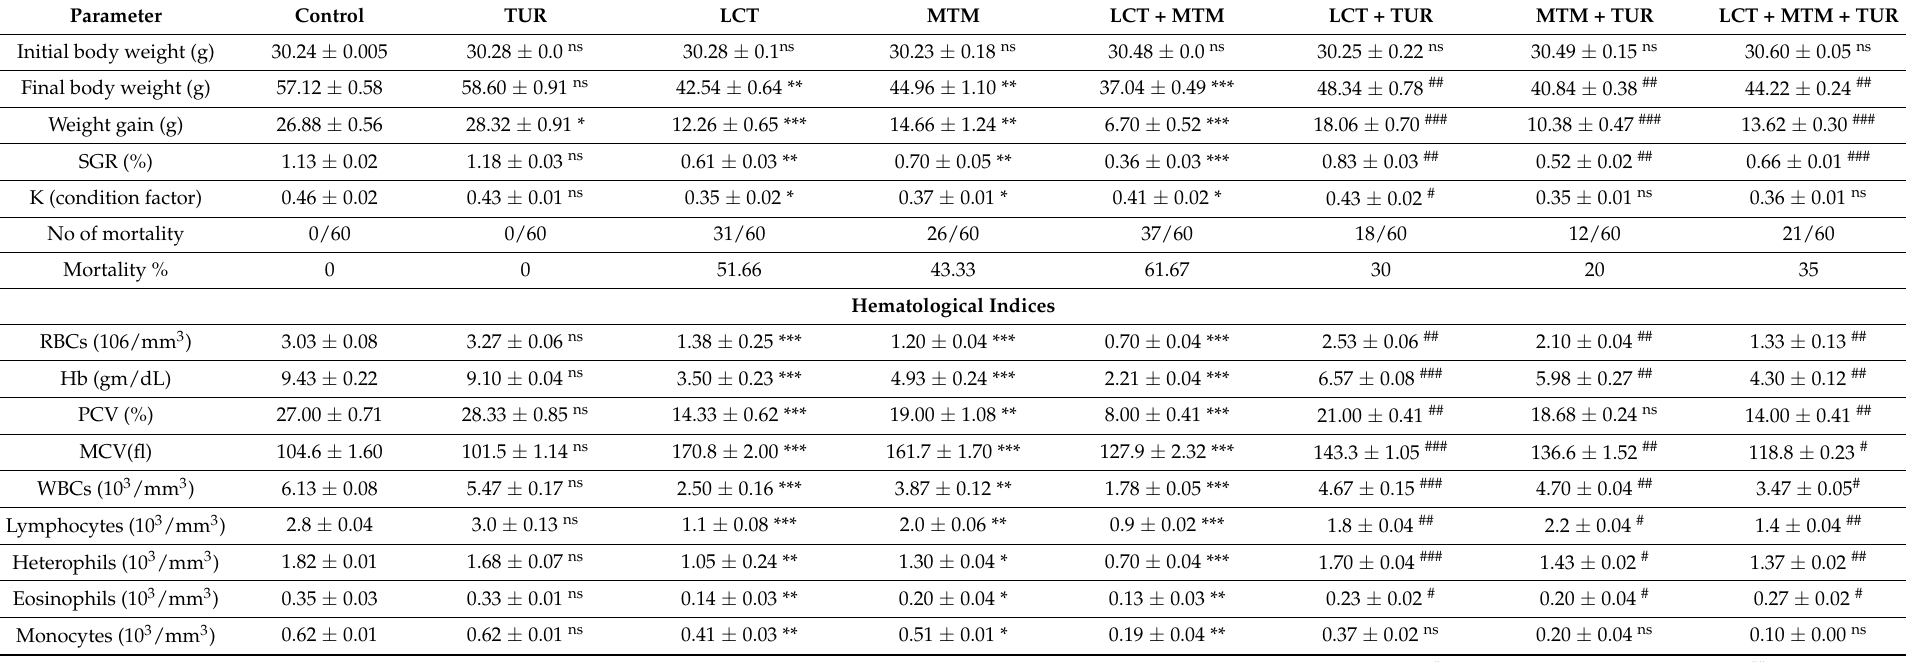
Table 4. Comparative and combined effects of LCT and MTM (1/20 of LC 50 ) on growth performance hematological indices on O. niloticus and the role of Taurine (1% in diet). For 60 days ( n =